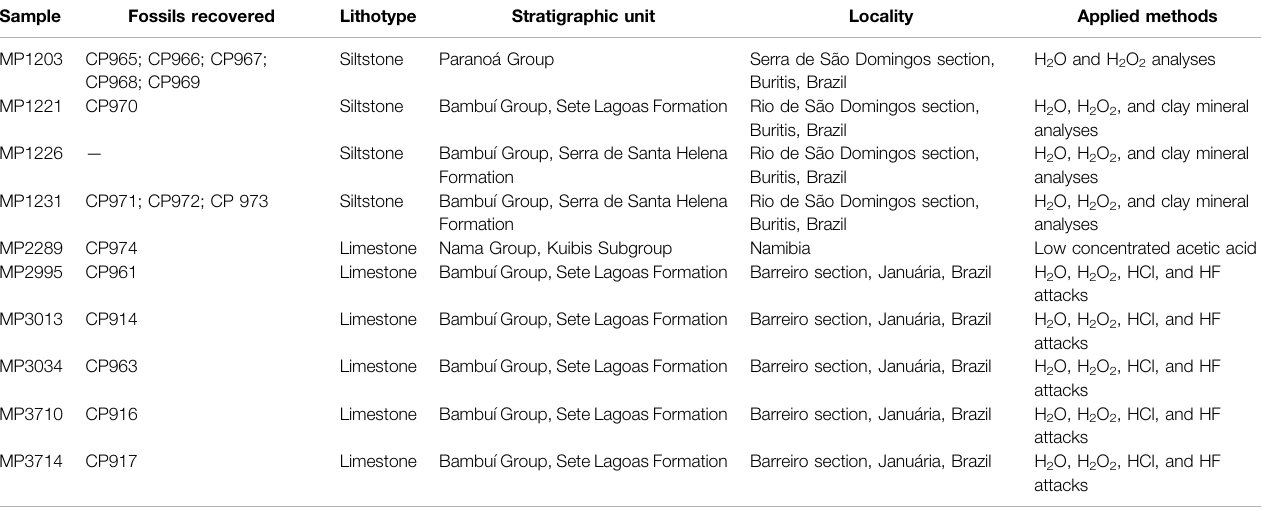
TABLE 1 | Samples from Ediacaran units analyzed for speci fi c preparations.